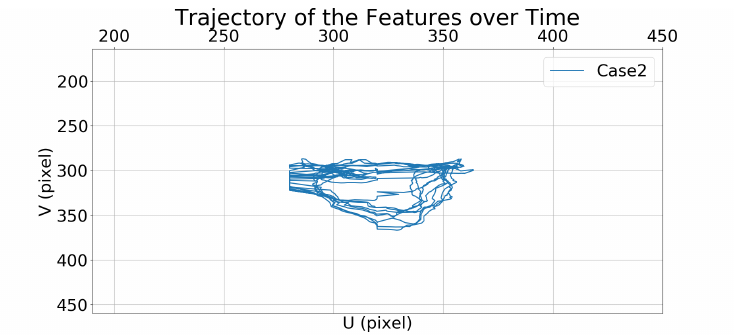
Figure 8. Simulation 1: trajectory of the moving target in the image frame for Case 1.